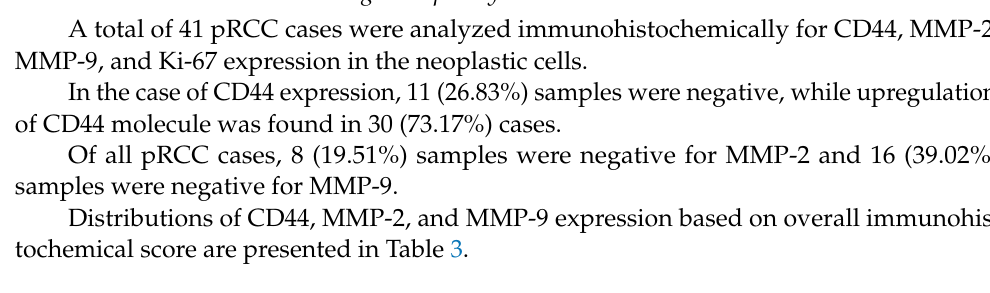
Table 3. CD44, MMP-2, and MMP-9 immunoreactivity of papillary renal cell carcinoma.